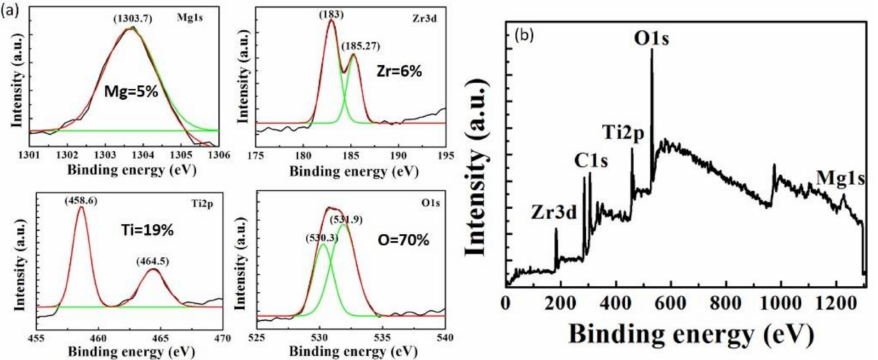
Figure 5. ( a ) Mg1s, Zr3d, Ti2p, and O1s peaks from the XPS spectra. ( b ) XPS survey spectrum of the MZT thin film.